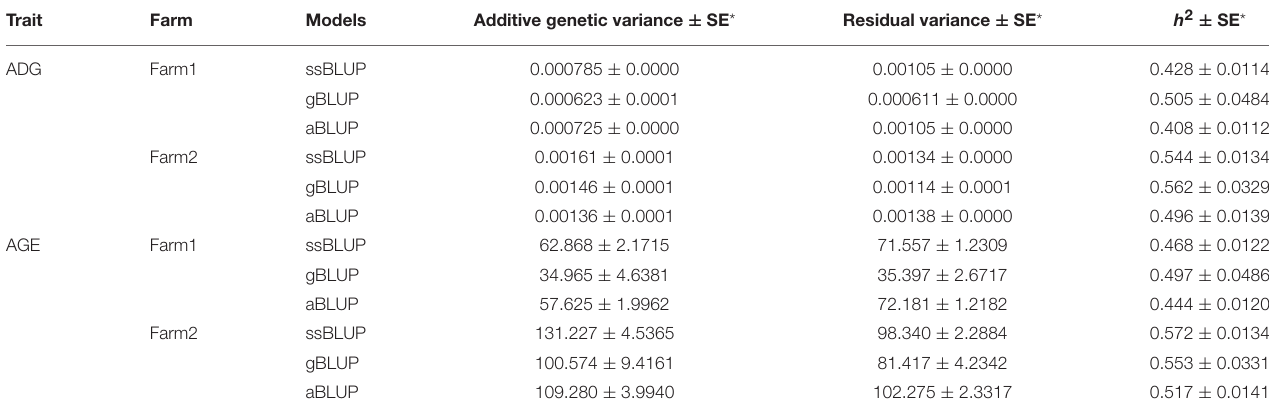
TABLE 2 | Estimation of genetic parameters for ADG and AGE that adjusted to 100kg.